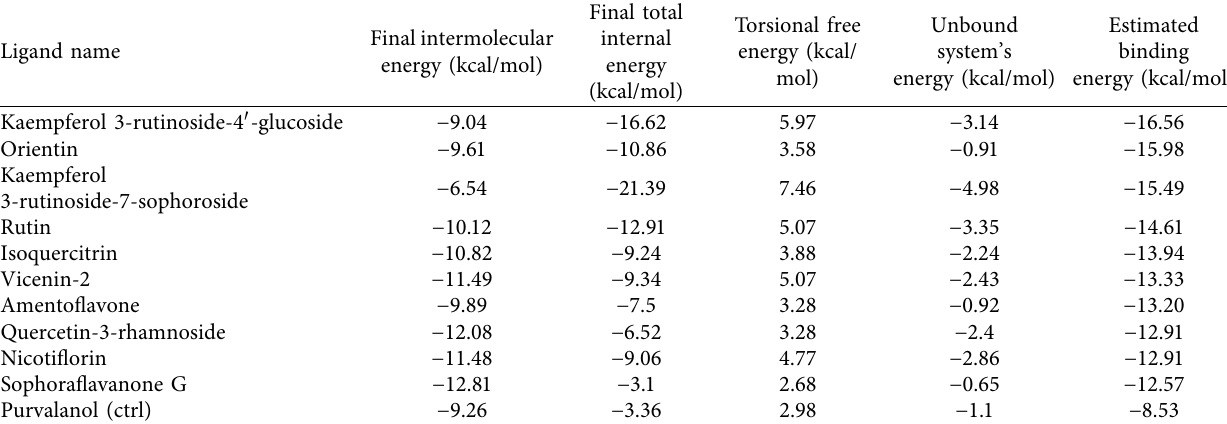
MAPK3, mitogen-activated protein kinase 3; ctrl, control. Table 3: Schr ¨ odinger Maestro docking scores and relative binding free energies (kcal/mol) of top-ranked favonoids (based on